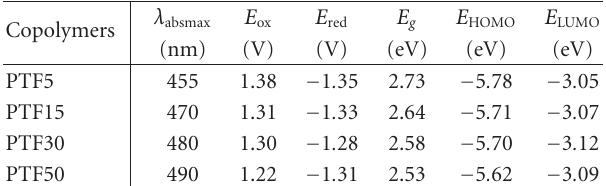
Table 1: Wavelength at peak absorption and electrochemical prop- erties of PFTs.